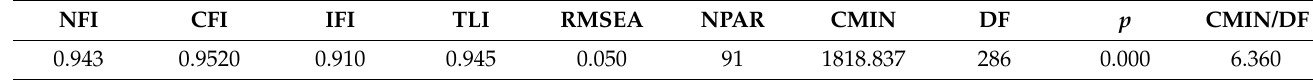
Table 1. Model fit indices.